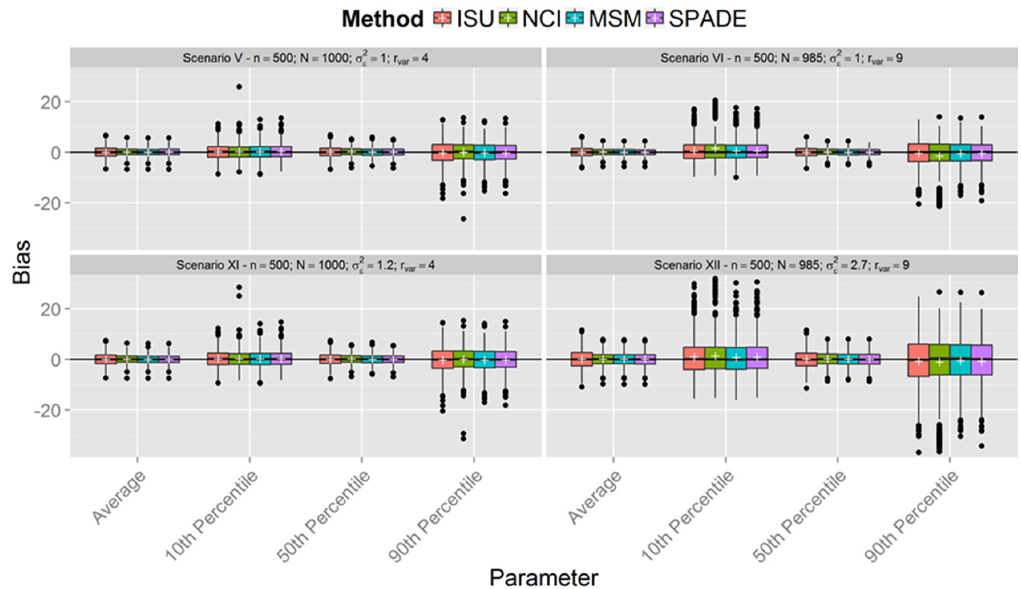
Figure 3. Boxplot of biases calculated for each method and scenarios with n = 500 for samples with estimated between ‐ person variance different from zero for all methods (N denotes the number of usable samples).